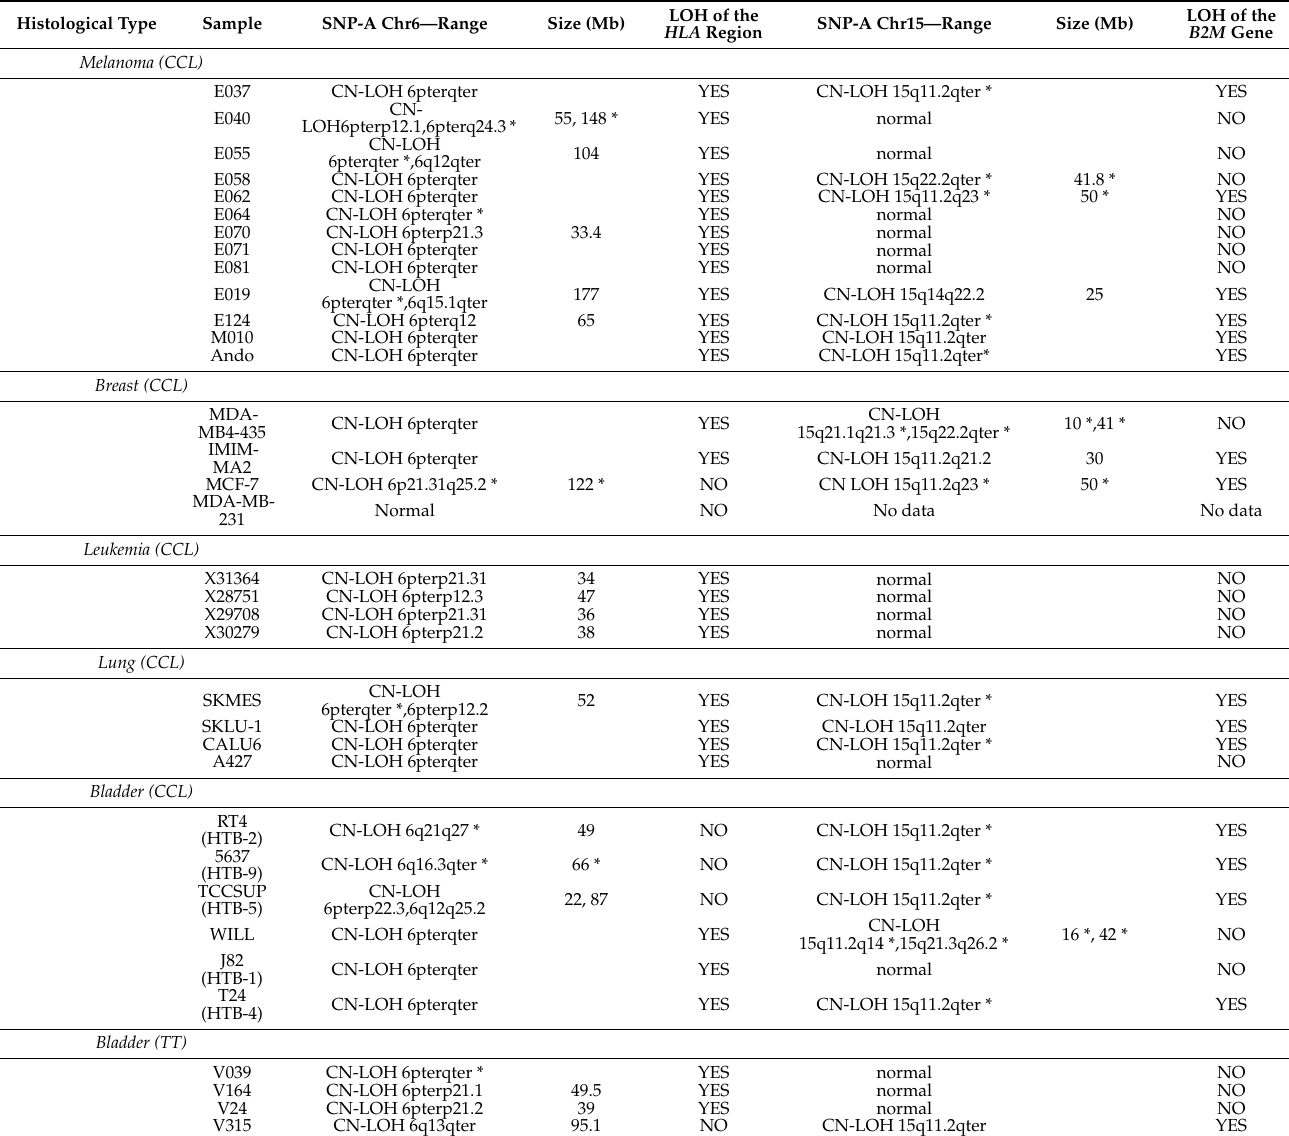
Table 1. Analysis of the LOH in chromosomes 6 and 15 in human tumor cell lines and bladder